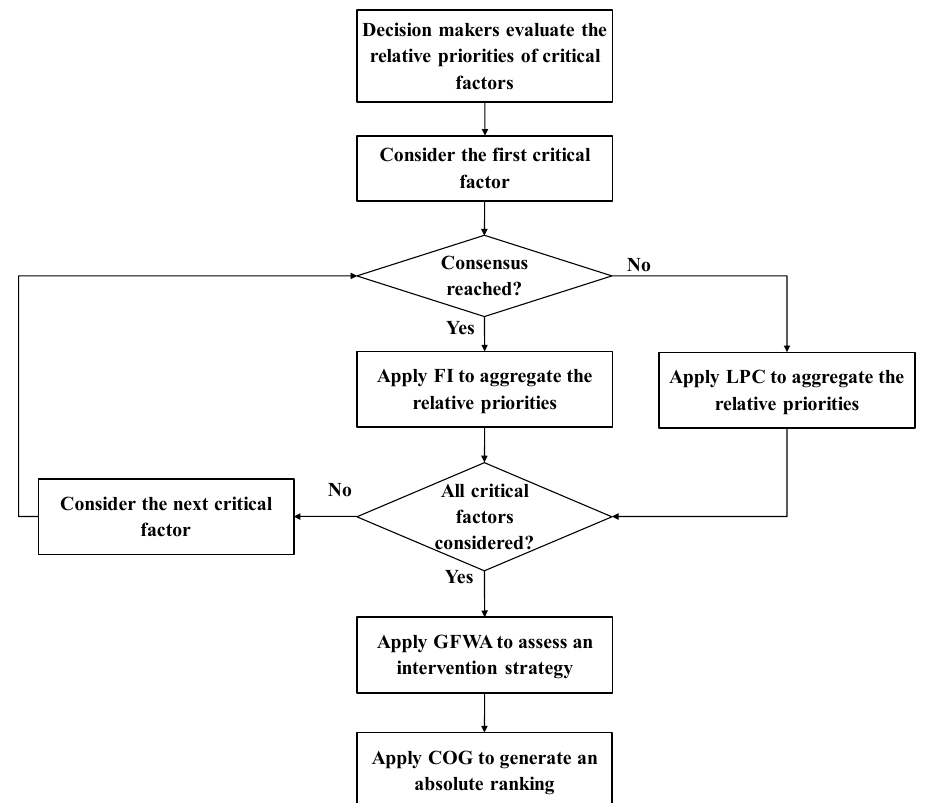
Figure 1. Implementation procedure of the varying partial consensus fuzzy collaborative intelligence approach.